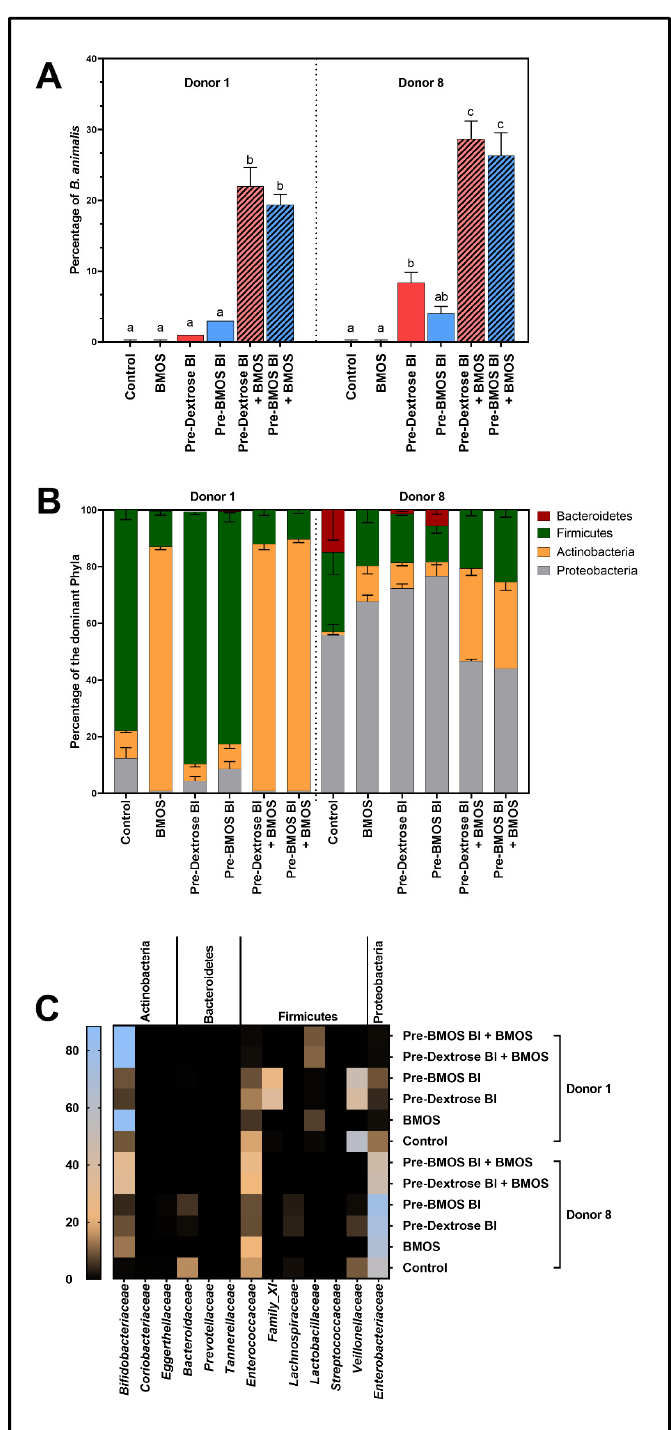
Figure 2. Mean ( ± standard deviation) relative abundance (%) of the dominant phyla ( B ) (through a heat map), families ( C ) and specifically of B. animalis ( A ) upon a 48 h fermentation of 5 g / L BMOS containing 1.5 × 10 7 CFU / mL of B. lactis previously grown on either Dextrose (Pre-Dextrose Bl + BMOS, n = 3) or BMOS (Pre-BMOS Bl + BMOS, n = 3), by an infant fecal microbiota of Donors 1 and 8, versus their respective controls (Control, Pre-Dextrose Bl and Pre-BMOS Bl, n = 3). Significant di ff erences between the di ff erent formulations within each donor are indicated with di ff erent letters (a, b, c), as tested with a one-way ANOVA with Tukey’s HSD post hoc test ( p < 0.05). In contrast, when at least one letter is shared between two treatments, there was no significant di ff erence between these